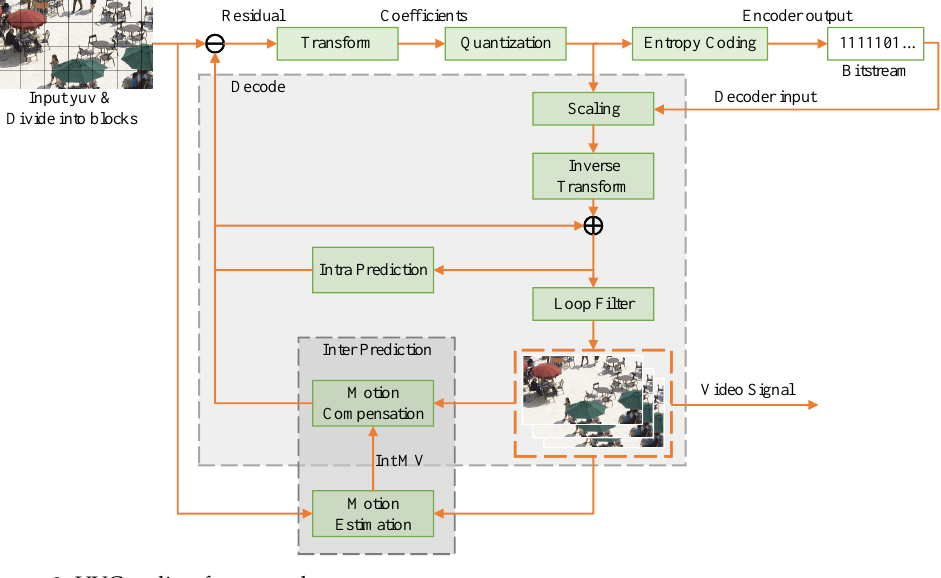
Figure 3. VVC coding